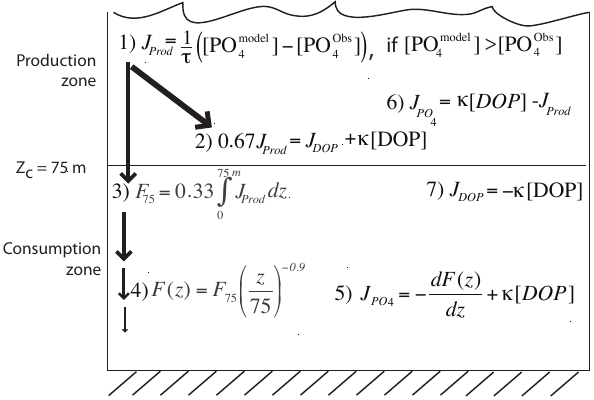
Fig. 3. A schematic showing the governing equations of the OCMIP-2 biological model. Terms that begin with the letter J are source/sink terms (black text), while terms that begin with the letter F are flux terms (grey text). At depths shallower than 75m, model PO 3 − (PO model ) in excess of a seasonal climatology 4 4 (PO Obs ) (Louanchi and Najjar, 2000) fuels new production ( J Prod ), 4 thus restoring the surface model to climatological values over a time scale of τ = 30 days (Eq. 1). The resulting productivity has two fates: two thirds becomes a source term for DOP ( J DOP , Eq. 2), and one third fuels a parameterized sinking flux of organic phosphorus, that is shunted to 75m ( F 75 , Eq. 3). Below 75m, the sinking flux decays as a function of depth (Eq. 4). The vertical divergence of this sinking flux is a source term of PO 3 − (Eq. 5). DOP is reminer- 4 alized to PO 3 − everywhere in the model, at a rate of κ = 0.5 year-1 4 (Eqs. 5 and 6). This DOP to PO 3 − decay is a sink term for DOP 4 ( − κ [DOP], Eqs. 2 and